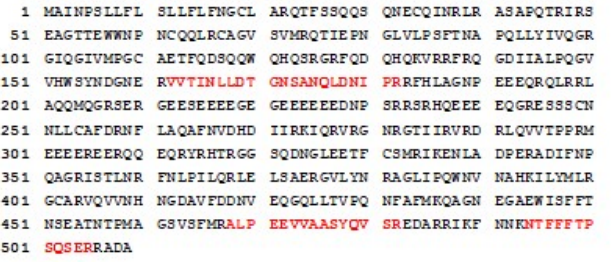
Table 3. C72 Vicilin Sequence Homology.